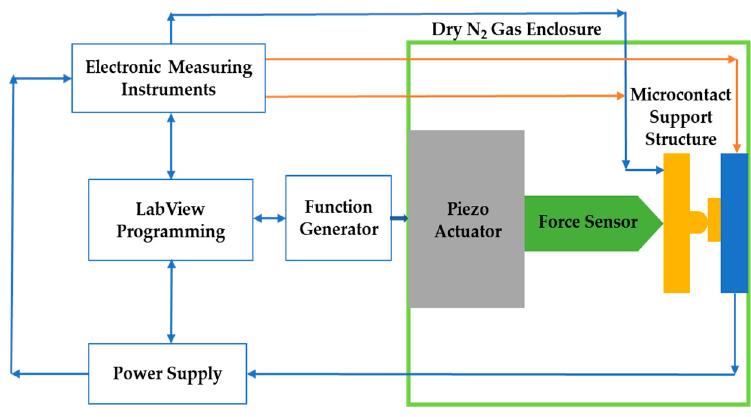
Figure 2. Schematic representation of the microcontact test fixture assembly.